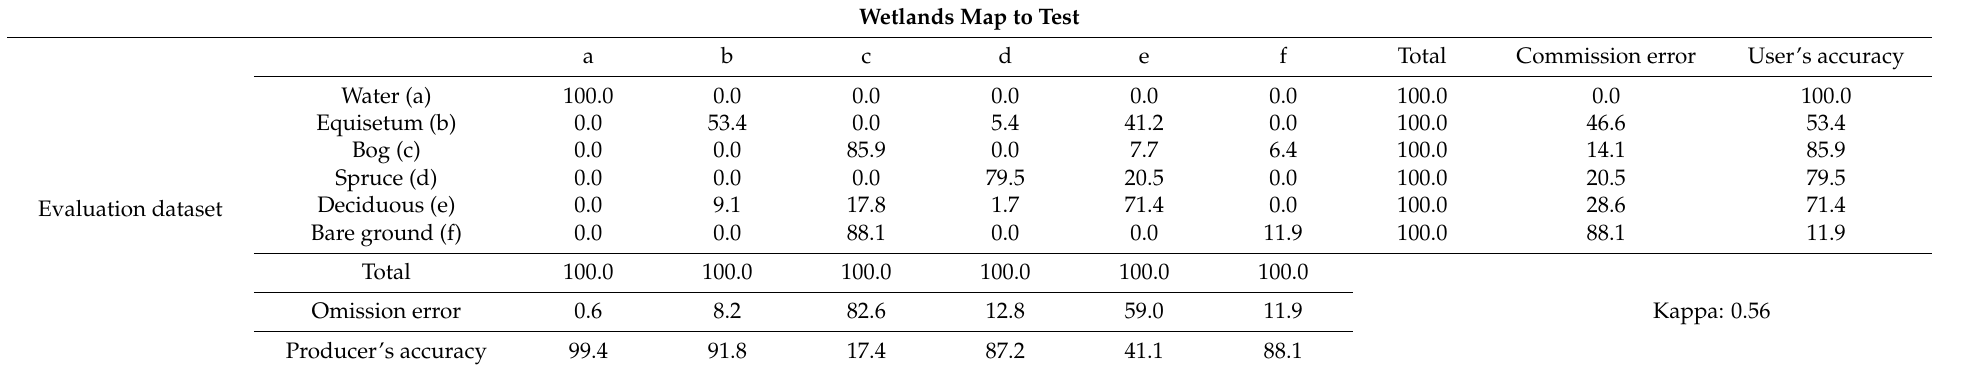
Table A2. Confusion matrix for area B hybrid classification. Results in